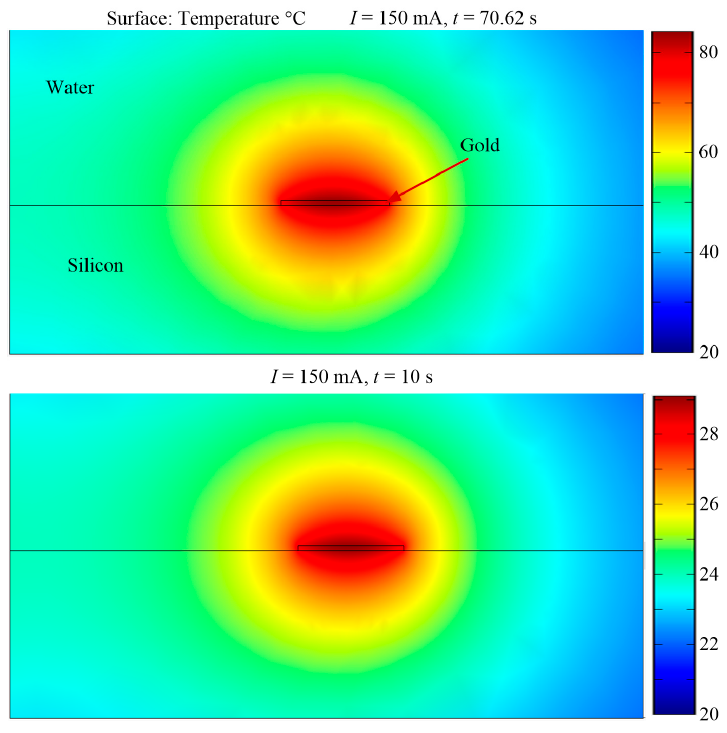
Figure A3. Cont . Figure A4. Cont